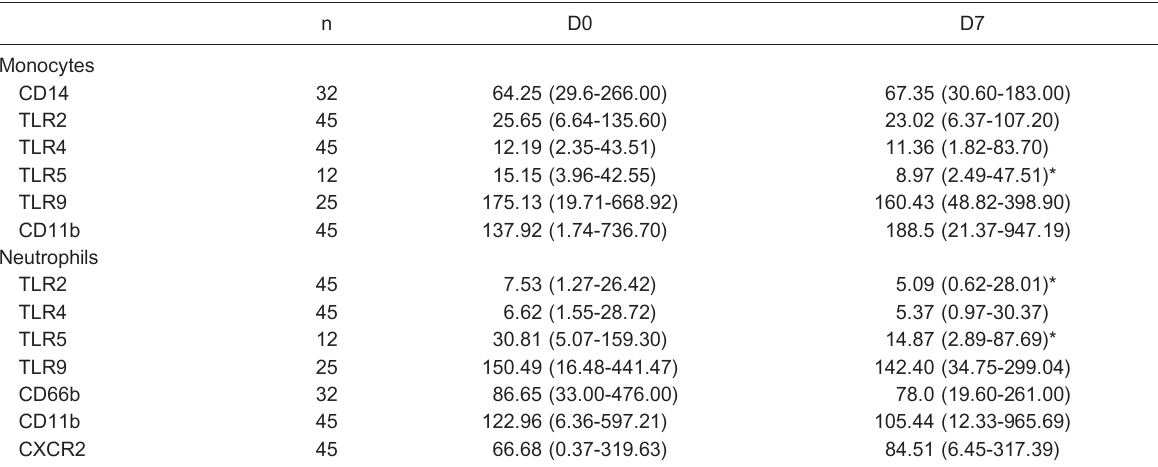
Table 2. Expression of receptors at baseline and follow-up of the septic patients.